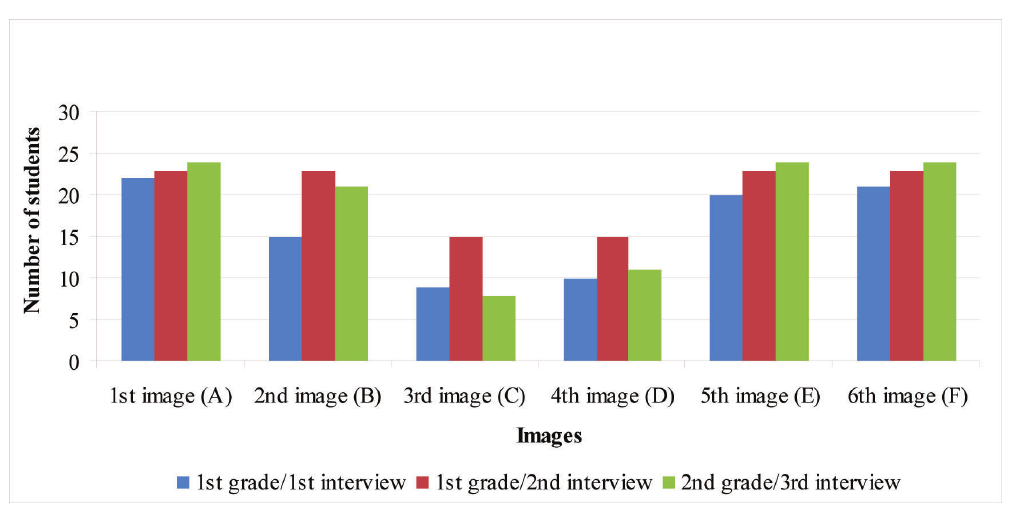
Figure 1: Number of students who correctly ordered pictures in the first grade (first and second interview) and second grade (third interview)